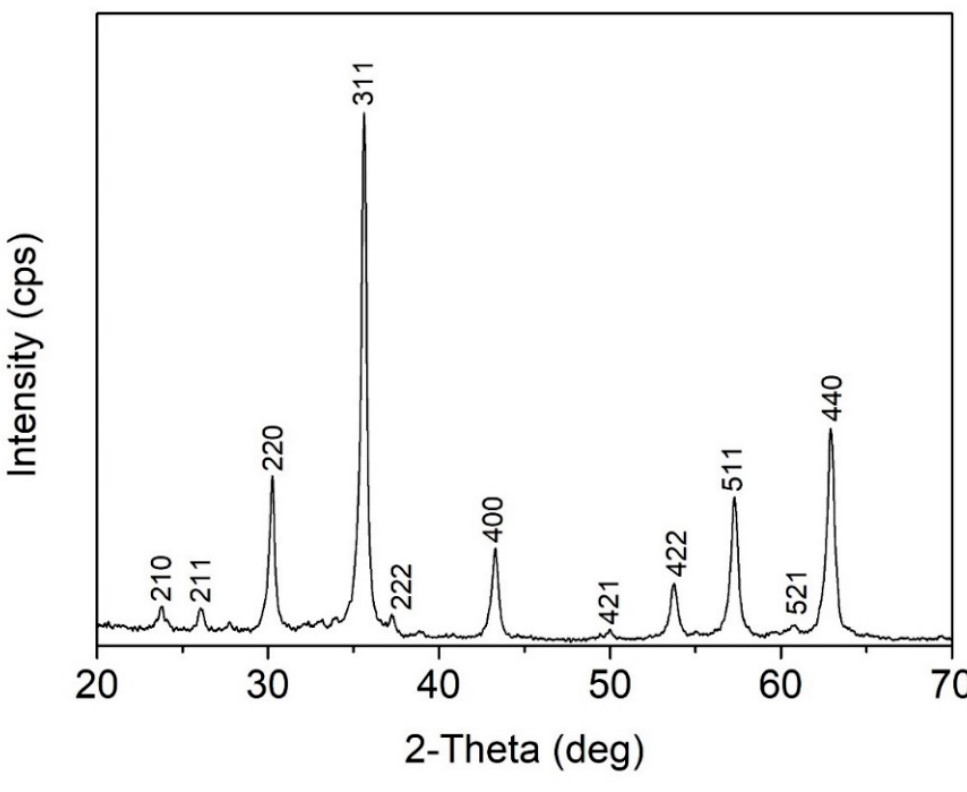
Figure 3. XRD patterns of Fe 2 O 3 NPs.